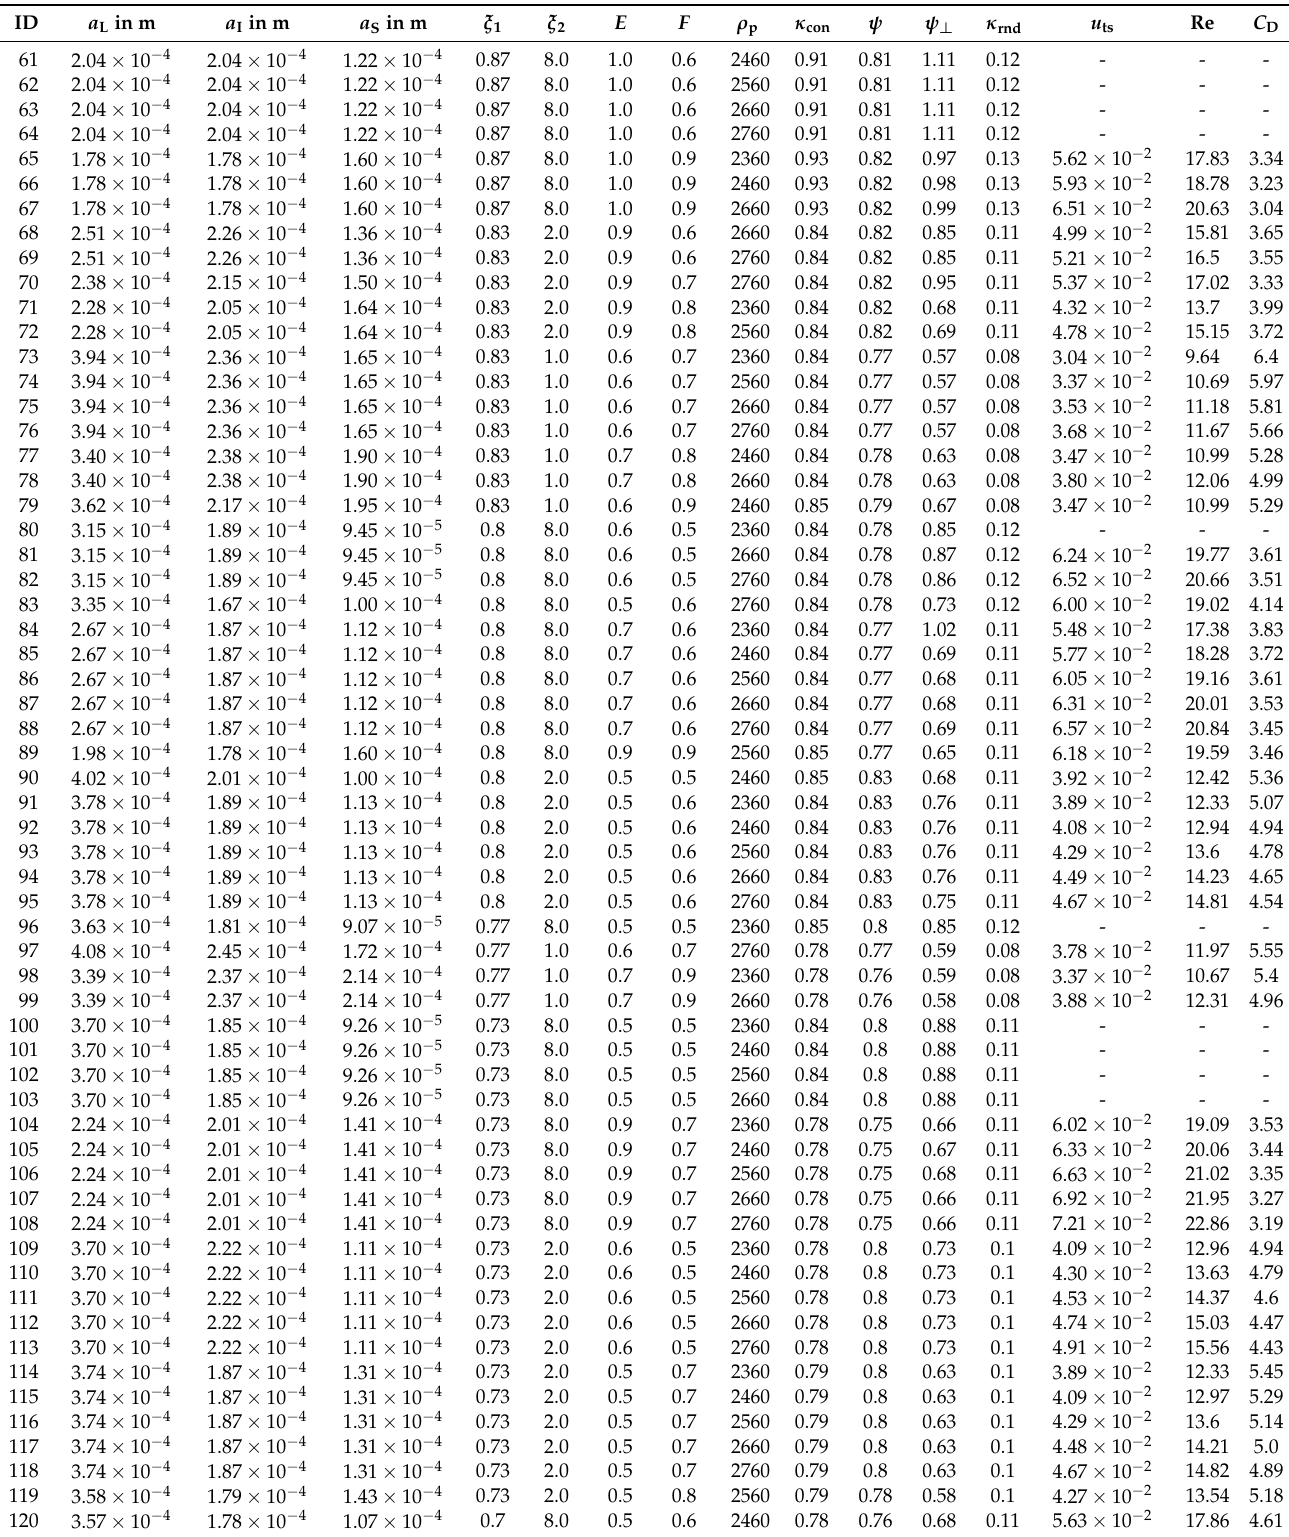
Table A2. Data of the particles in the training